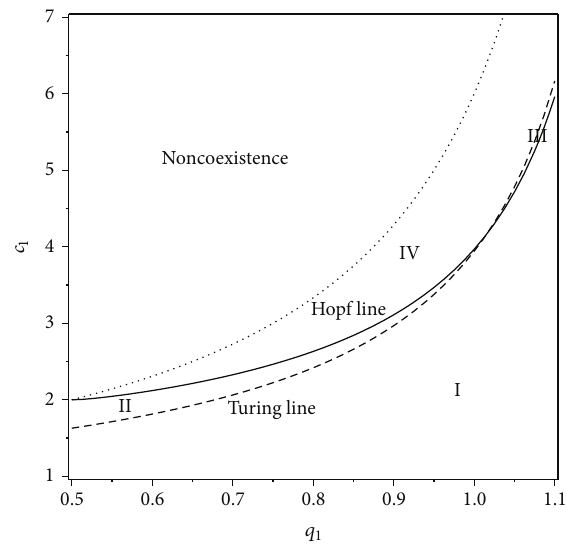
Figure 1: 𝑐 1 - 𝑞 1 bifurcation diagram for model 3 with 𝑚 1 = 1.5 , 𝑚 2 = = 1 , 𝑐 = 0.5 , 𝑑 = 0.01 , 𝑑 = 0.1 , 𝑑 = 1 , and 𝑞 2 , 𝑞 2 2 1 2 3 1 a variational parameter. Hopf and Turing bifurcation curves separate the coexistence parameter space into four domains. ... : the dividing line of coexistence and noncoexistence of prey and their